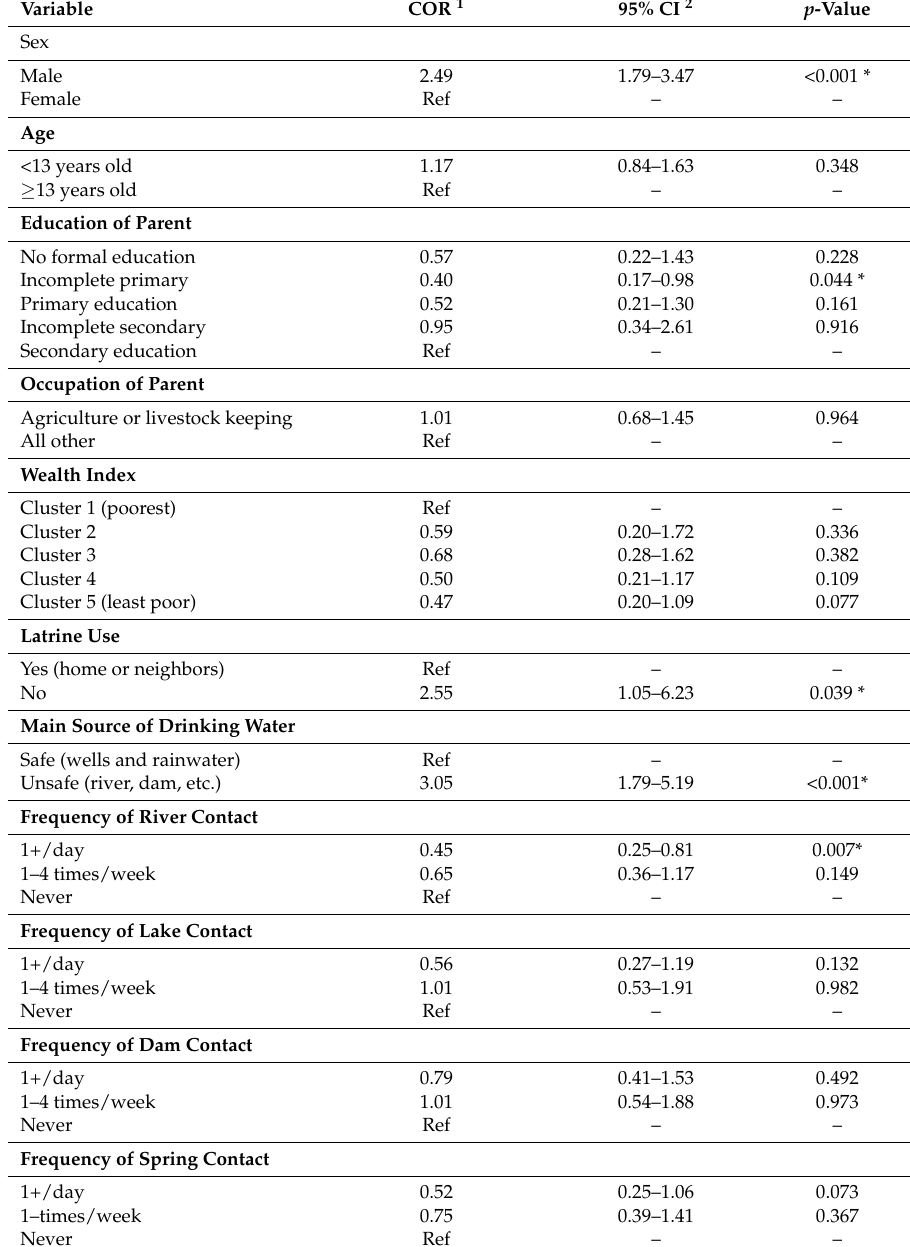
Table 6. Univariable mixed effects logistic regression analysis of risk factors associated